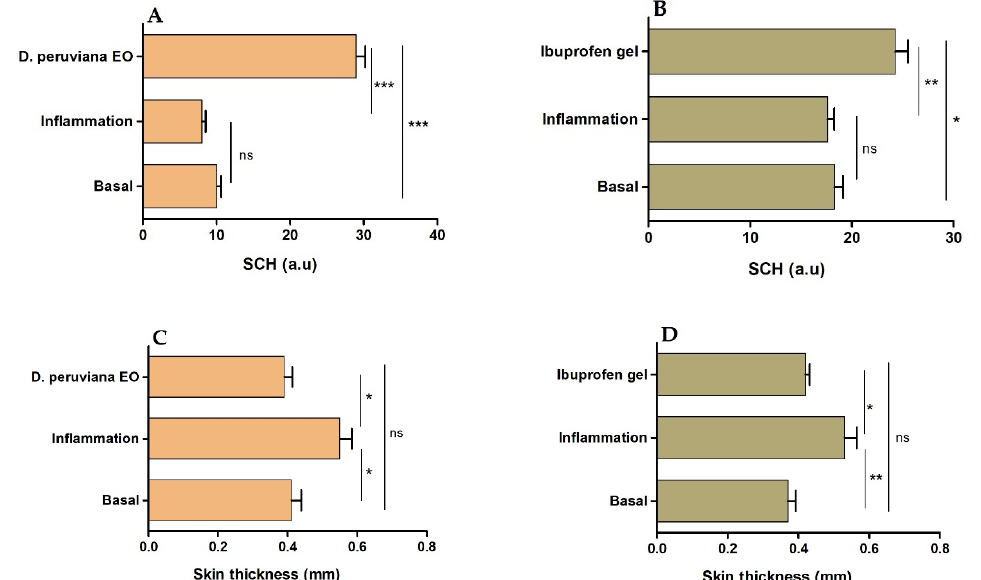
Figure 2. Stratum corneum hydration (SCH) and skin thickness of the mouse ears. ( A ) SCH of skin treated with D. peruviana EO, ( B ) SCH of skin treated with reference drug (Ibuprofen gel), ( C ) thick- ness of skin treated with D. peruviana EO, and ( D ) thickness of skin treated with reference drug (Ibuprofen gel). Mean ± SD of three replicates. Statistically significant difference: * = p < 0.05, ** = p < 0.01, *** = p < 0.001, ns: no significant.